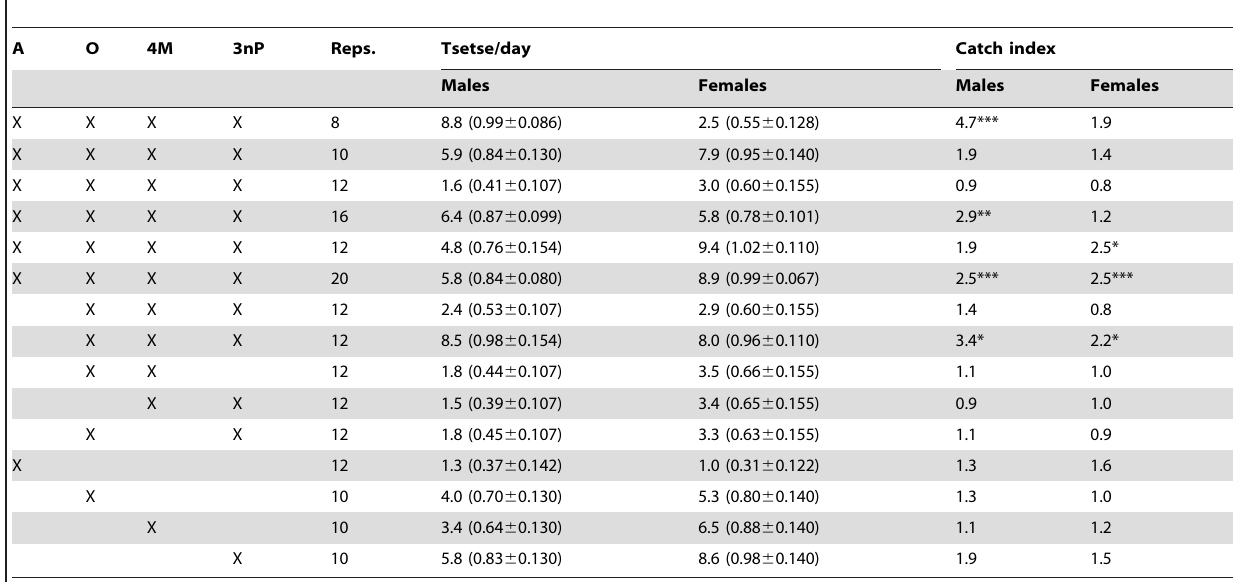
Table 6. Detransformed mean daily catch (transformed means 6 SED in brackets) of G. p. gambiensis from traps baited with synthetic host odours.